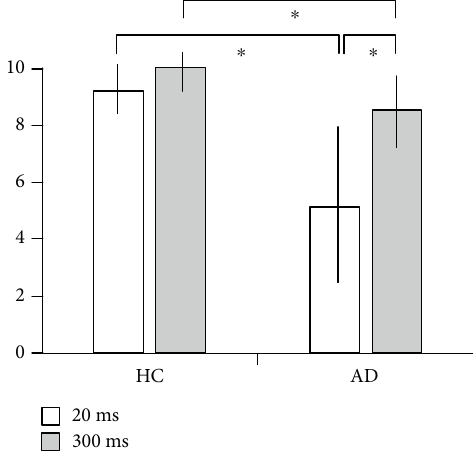
Figure 1: Comparison of the performances of the two groups. AD = Alzheimer ’ s disease; HC = healthy control. ∗ p < 0 : 005 , post hoc test. The y -axis represents the average number of correct answers with SD. According to the two-way ANOVA with time as the repeated measure and with age and education as covariables, there was a signi fi cant group e ff ect ( F = 11 : 6 , p = 0 : 001 ) and a presentation time e ff ect ( F = 6 : 3 , p = 0 : 013 ), with a signi fi cant interaction ( F = 13 : 1 , p < 0 : 001 ). There was a signi fi cant e ff ect on the covariate for age ( F = 12 : 7 , p < 0 : 001 ), but not for education ( F = 1 : 9 , p = 0 : 173 ). A post hoc t -test showed that the AD group had a signi fi cantly lower score than the HC group in presentation time for both 20 ms ( t = − 6 : 77 , p < 0 : 001 ) and 300 ms ( t = − 3 : 58 , p < 0 : 001 ). A post hoc t -test in the AD group showed that the presentation time for 20ms has a signi fi cantly lower score than that for 300 ms ( t = − 17 : 26 , p < 0 : 001 ).